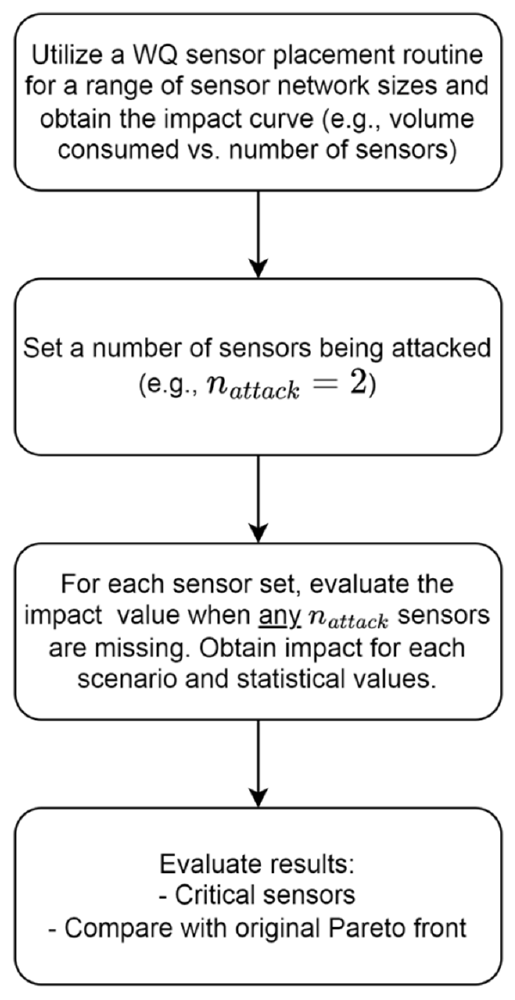
Figure 1. Schematic of the proposed methodology.